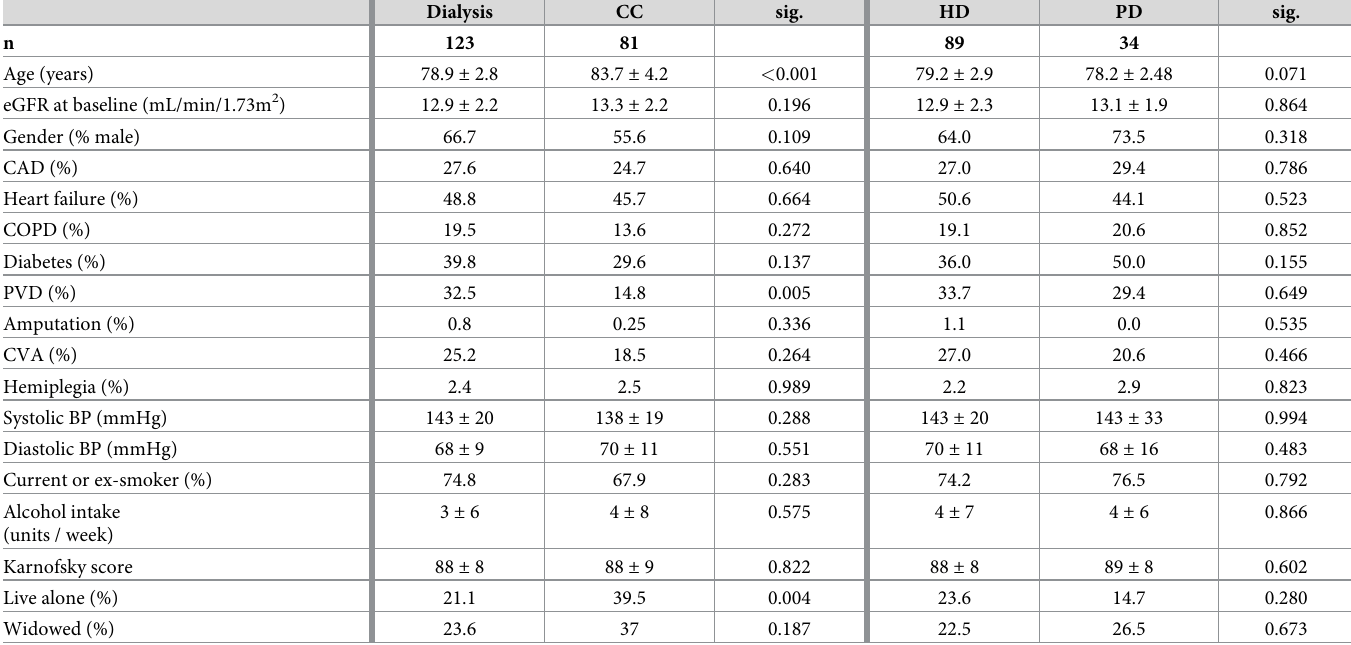
Table 1. Between group comparisons at baseline of first outpatient eGFR � 15 mL/min/1.73m 2 . Key: HD = haemodialysis; PD = peritoneal dialysis; CC = conservative